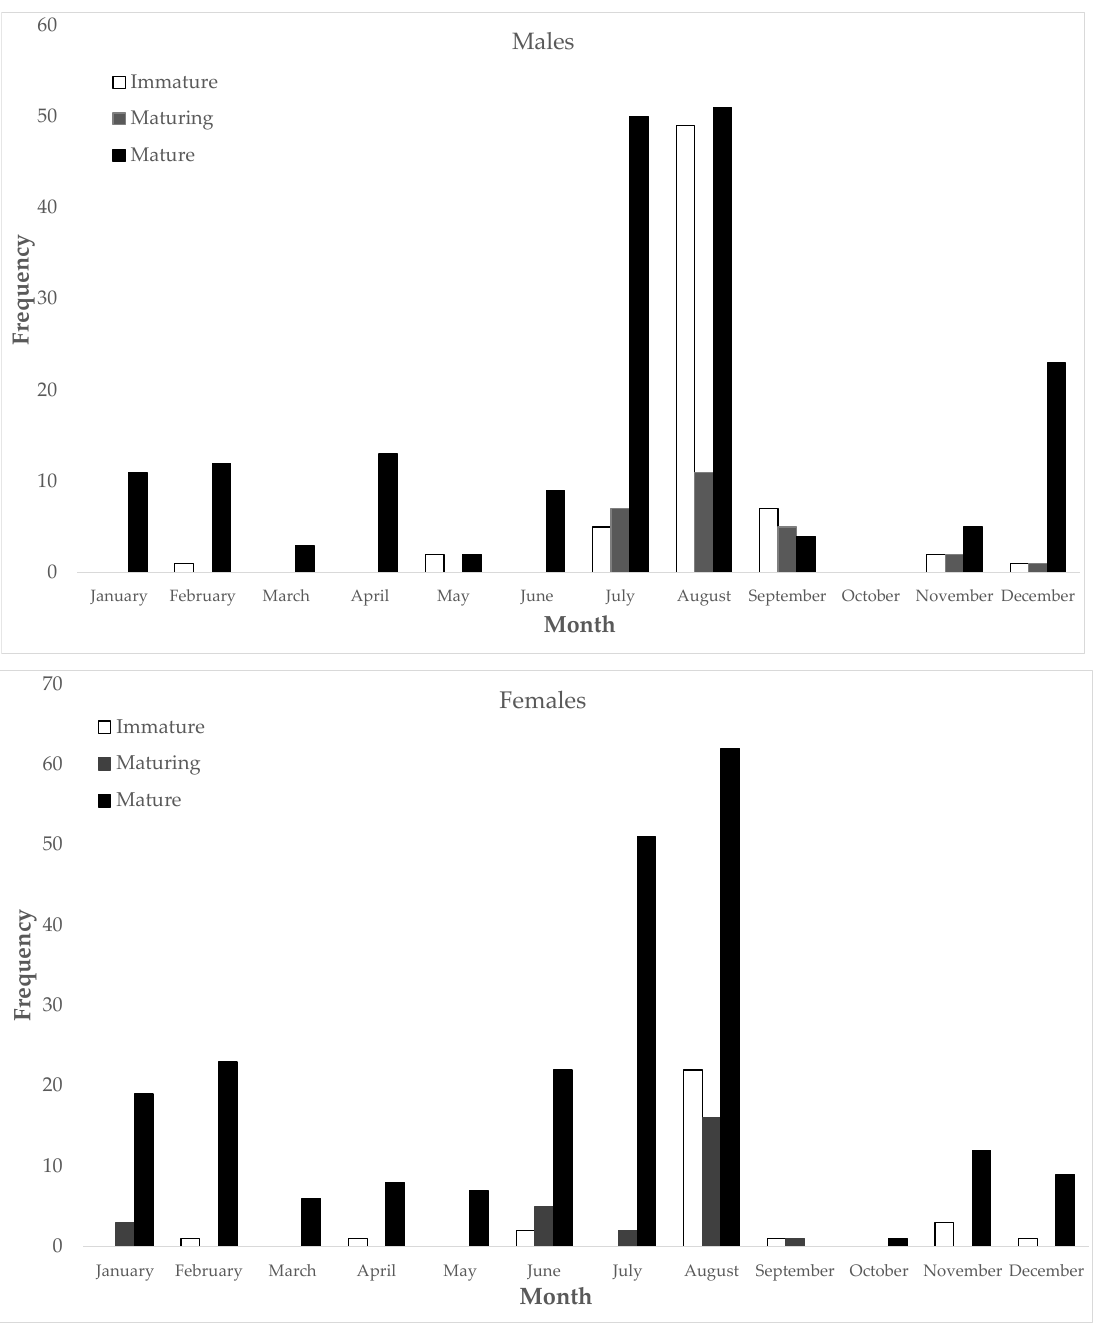
Figure 3. Seasonal variation in the maturity stages of U. chilensis in the SGC. As occurred with GSI and HSI , the seasonal variation in maturity organisms, the presence of gravid females in the catches and embryo and free-living organisms size suggested a biannual reproductive cycle, with two breeding seasons followed by ovulation, the first one at the end of the DCS which corresponds to February–March, and the other one at the beginning of the